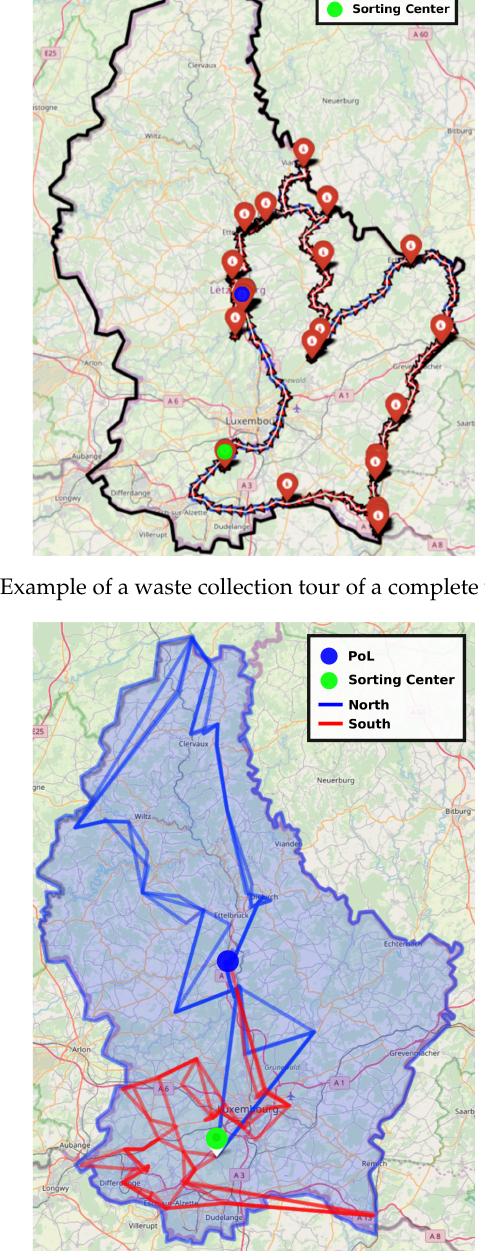
Figure 19. Successive collection paths on Monday (February 2019) for north and south